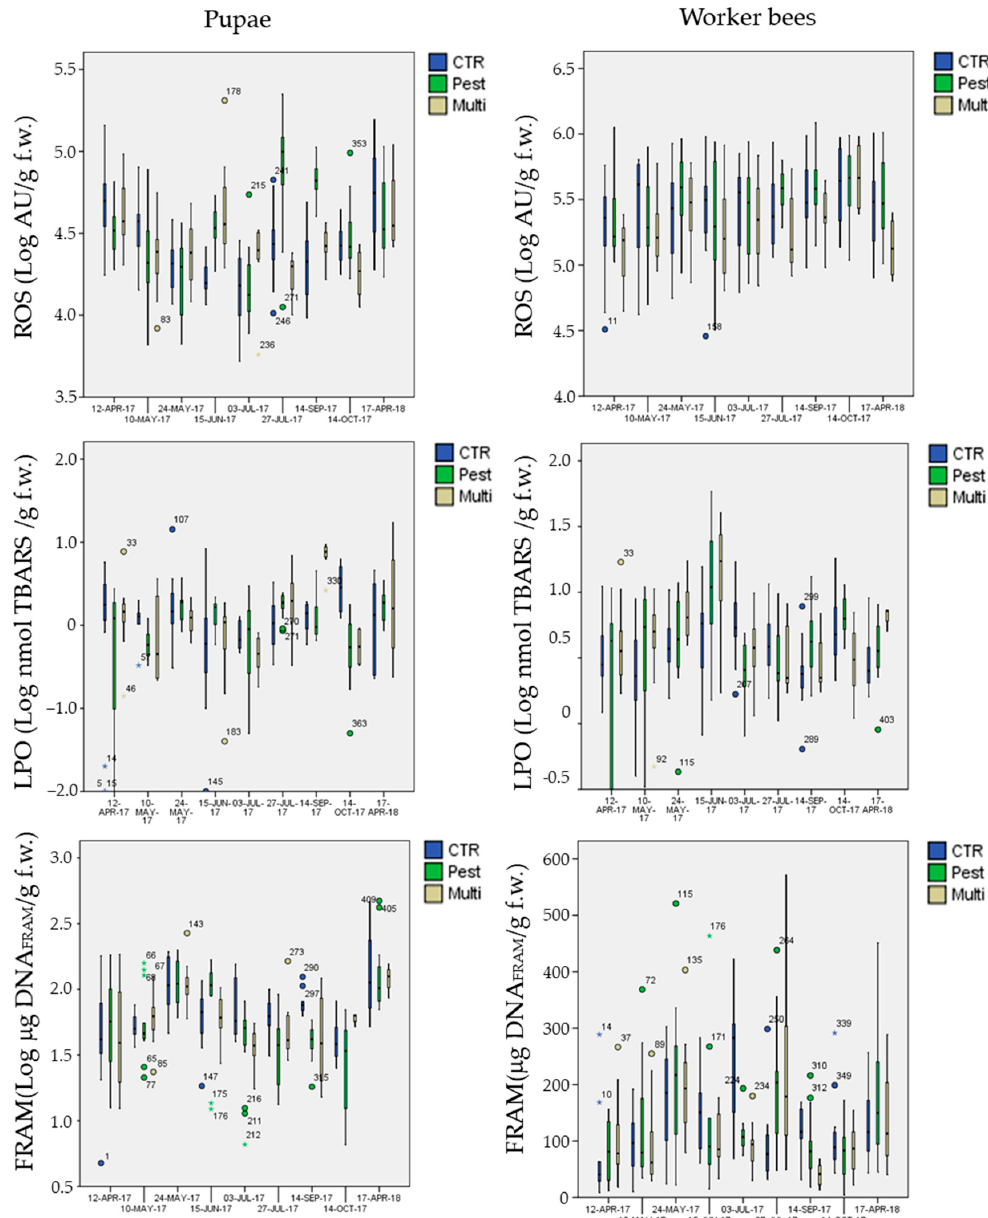
Figure 9. Box-plots of ROS, LPO, DNA FRAGM in the three experimental sites for pupae and worker bees as a function to the sampling date.